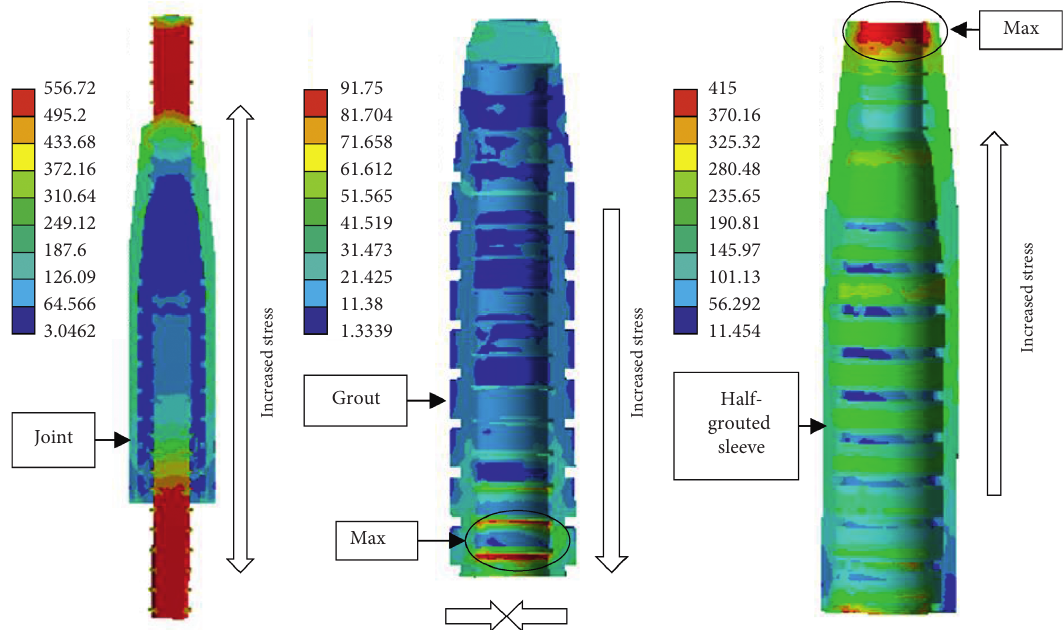
Figure 13: The finite element stimulation stress distribution diagram of the insufficient compactness specimen (unit: